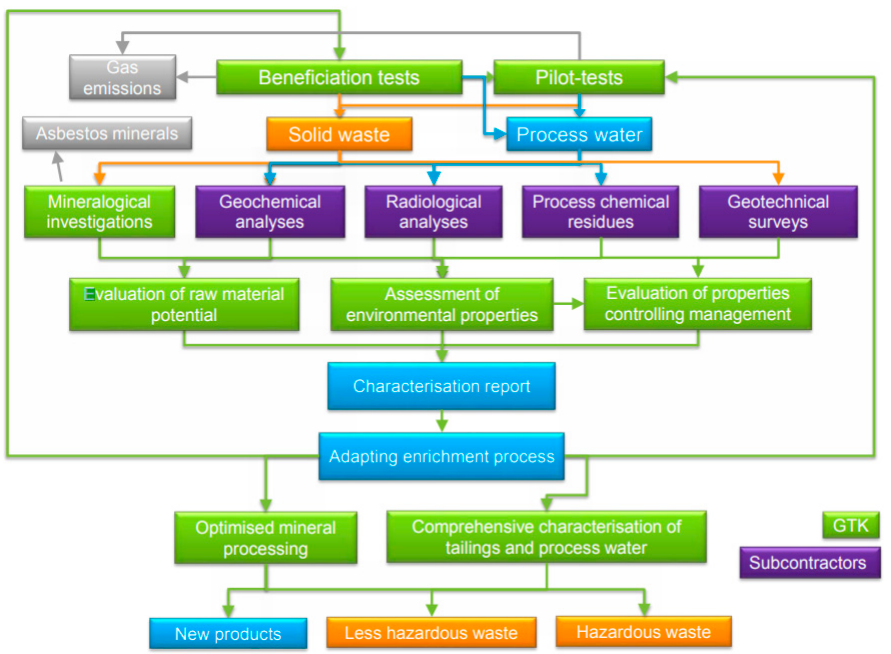
Figure 11. The operational model for the optimization of raw material potential and environmental properties of